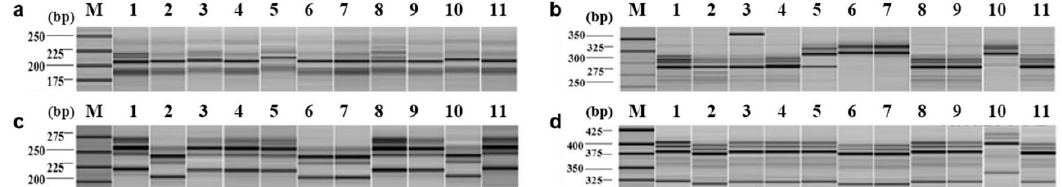
Figure 1. Polymorphism of four simple sequence repeat (SSR) markers, RM20754, HVSSR2-86, RM15641, and RM19731. The amplified polymerase chain reaction (PCR) products were loaded on the HAD-GT12™ Genetic Analyzer System and analyzed using Biocalculator Data Analysis Software.